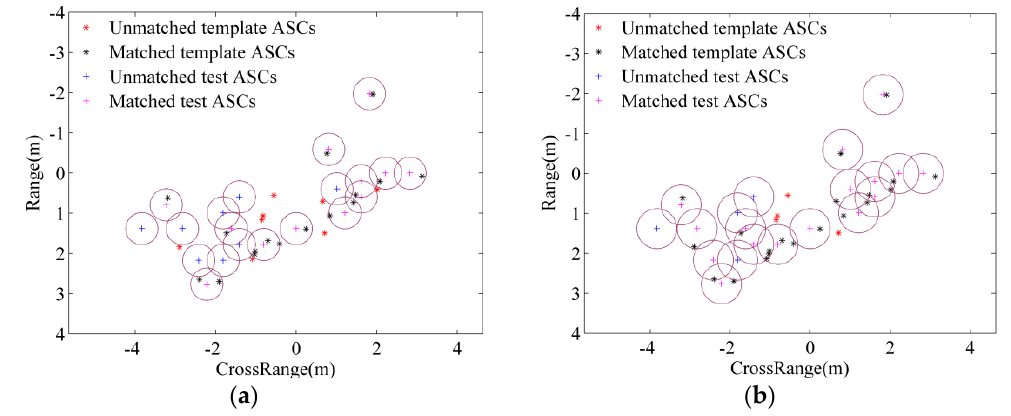
Figure 4. The neighbor matching results between the test and template ASC sets from BMP at the radius of ( a ) 0.4 m; ( b ) 0.5 m.